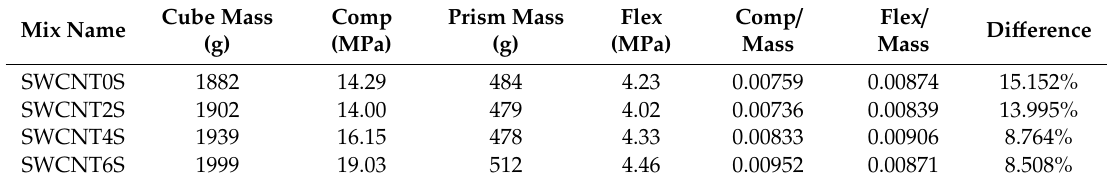
Table 15. Compressive (flexural) strength / mass ratio of cubes (prisms) at three days of